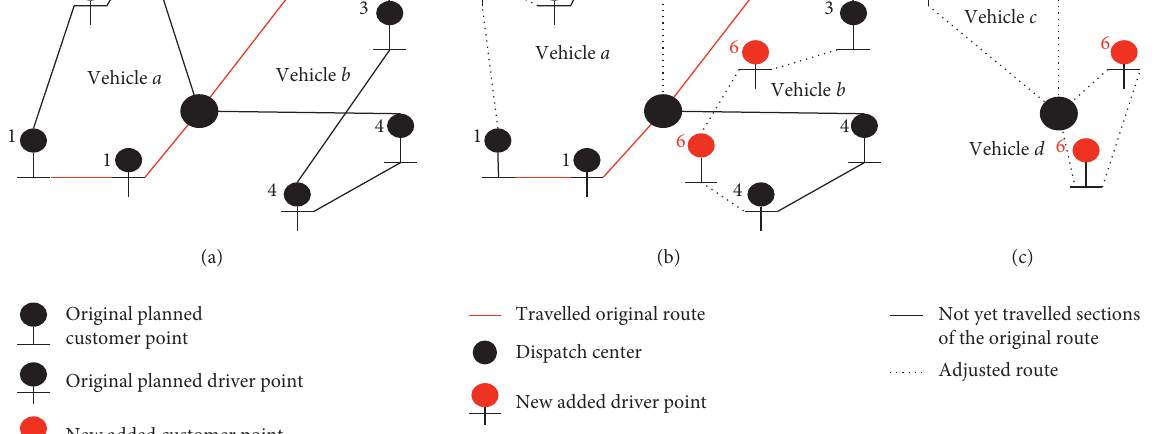
Figure 1: Vehicle dispatching.